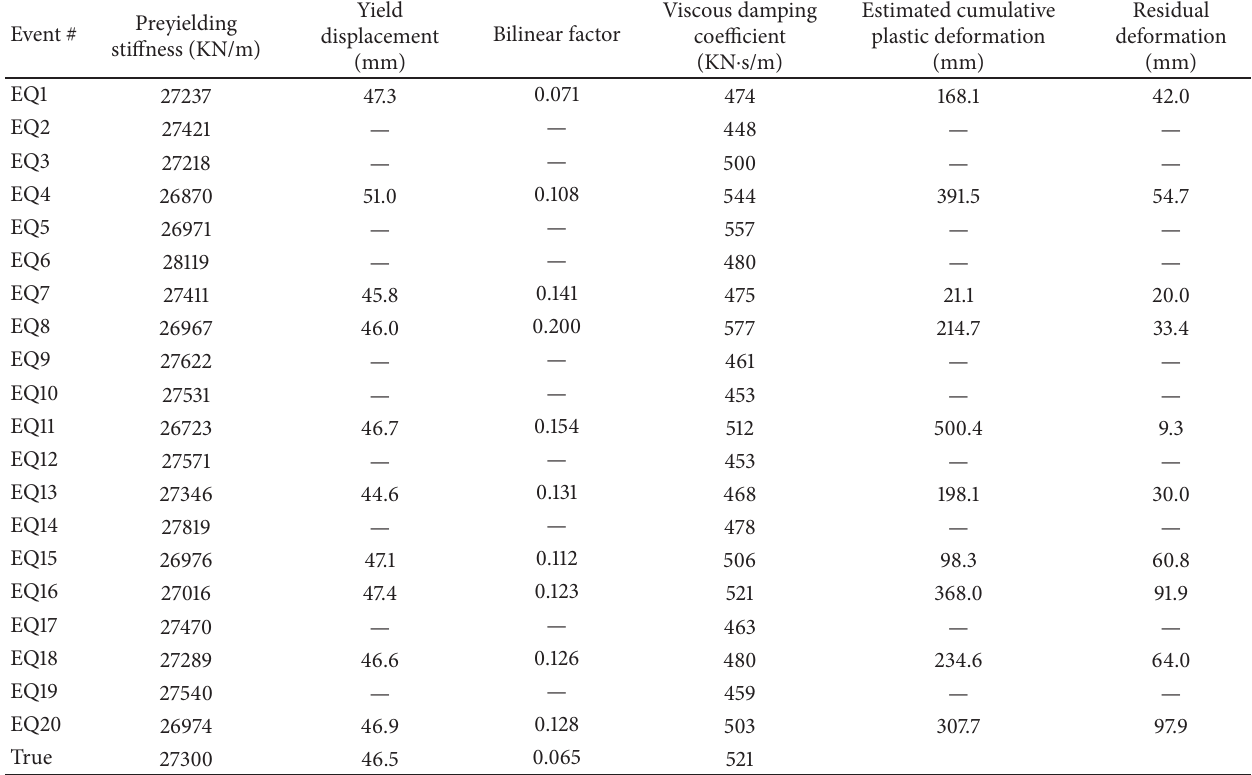
Table 6: Identification results for 20 seismic events with 10% RMS added